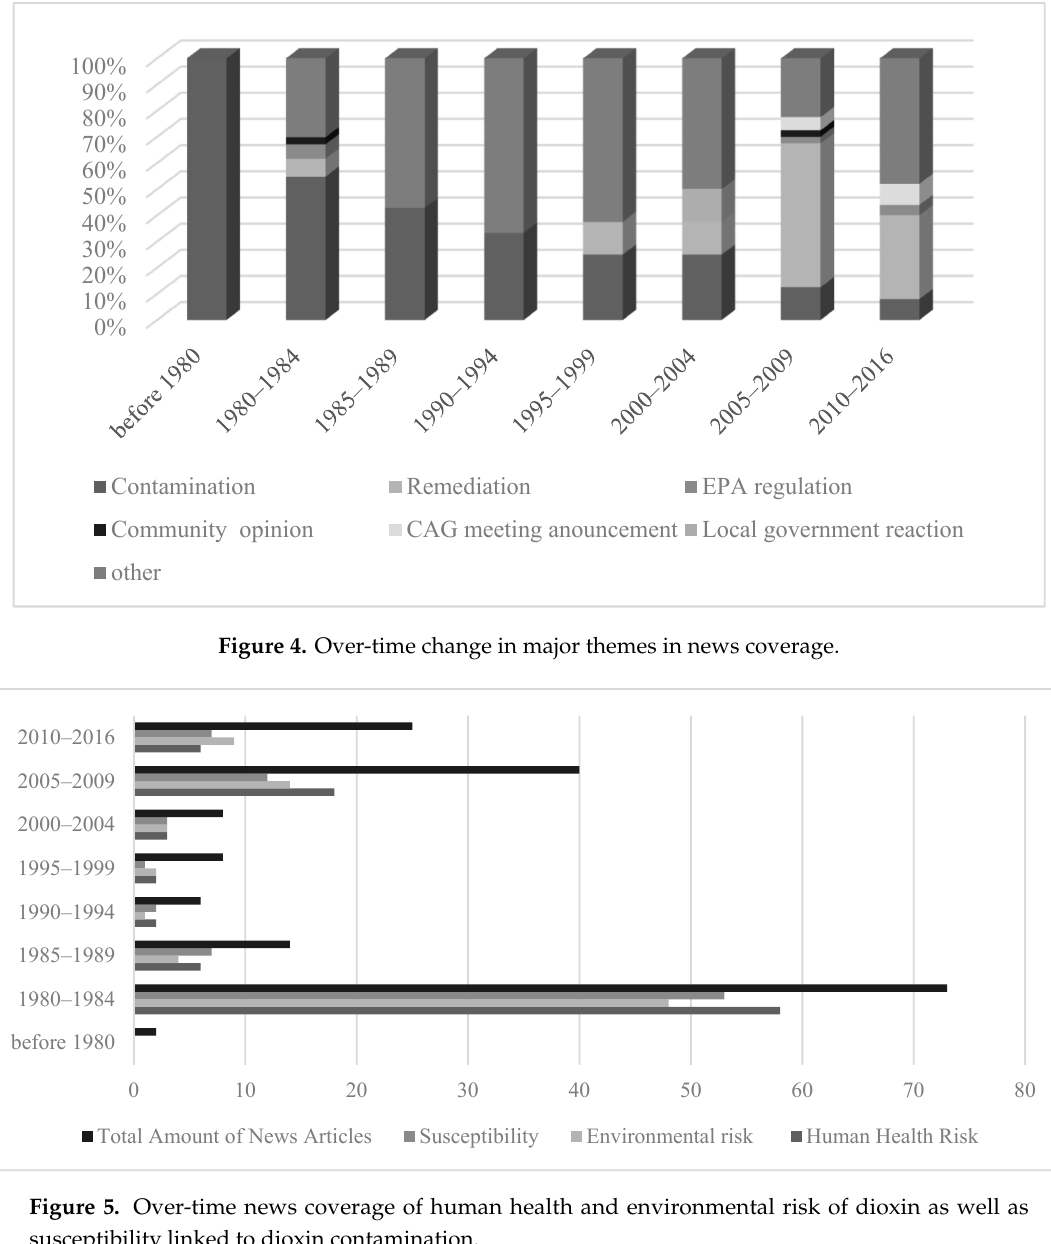
Figure 5. Over-time news coverage of human health and environmental risk of dioxin as well as susceptibility linked to dioxin contamination.